Question: State the chart type depicted above.
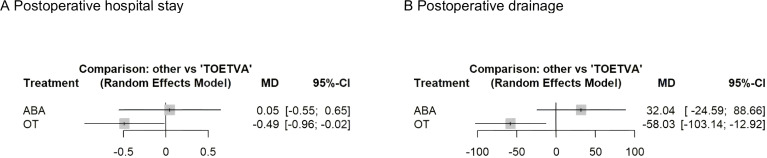
Answer: forest